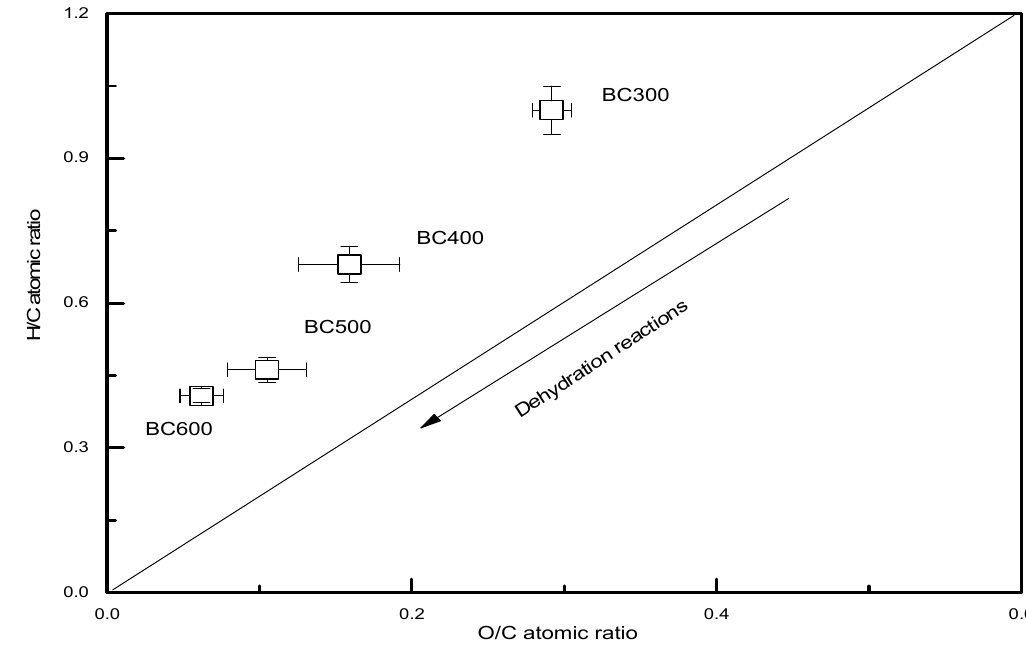
Figure 1. The van Krevelen plot of elemental ratios for biochars produced at different temperatures. Thick line represents the direction for dehydration reaction. Individual points are averages ( n = 3) and error bars are standard deviations.